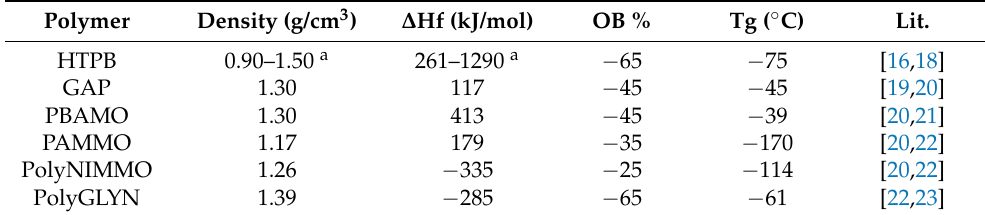
Table 2. Fundamental properties of typical binders.